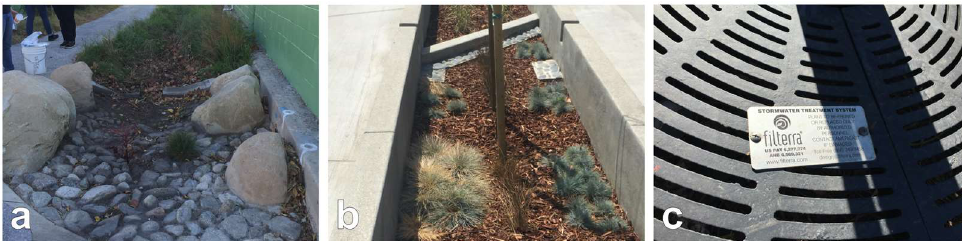
Figure 4. Examples of Los Angeles systems designed to remove debris and contaminants from runoff: ( a ) biofilter along Elmer Avenue Paseo, ( b ) biofilter in the Avalon Green Alley, and ( c ) Filterra™ bioretention system on Grand Boulevard.